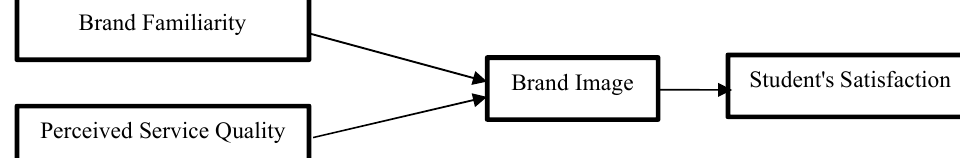
Fig. 1. Proposed model. BF=Brand Familiarity, PSQ= Perceived Service Quality, BI= Brand Image , SS= Student’s Satis- faction